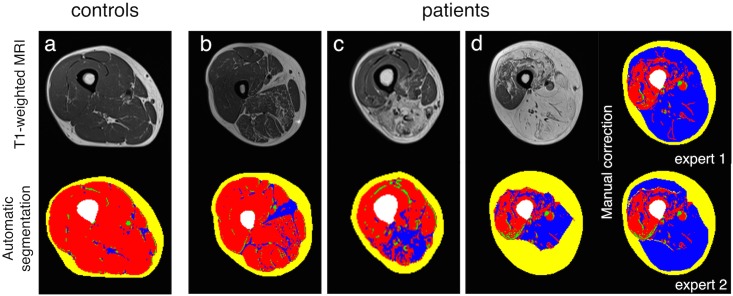
Examples of MR images.Examples of a successful automated segmentation in a control subject (a) and two patients (b and c). Examples of MR images with manual correction of the segmentation process (d).